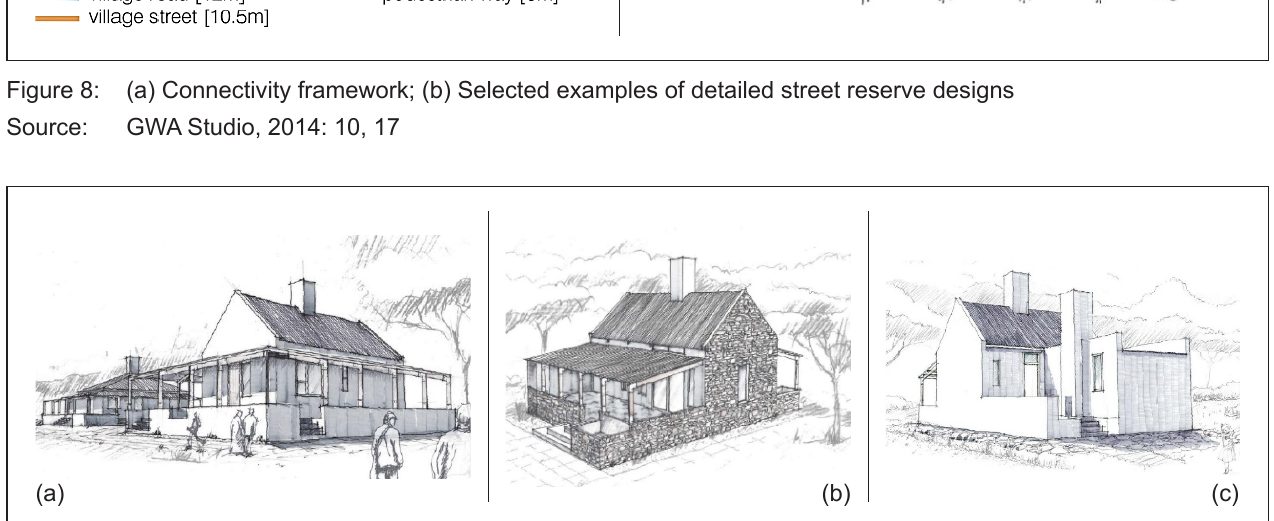
Figure 9: Selected housing typologies reflecting the regional vernacular architecture: (a) village home; (b) economic style with cultural influences; (c) hunter’s cottage